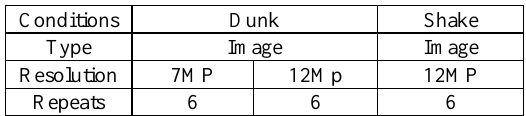
Table 2: Test series for data capturing for each of the three cameras with each six repeats.